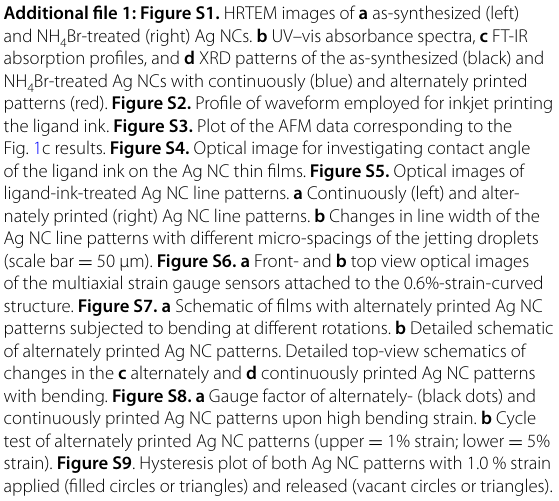
the ligand ink. Figure S3. Plot of the AFM data corresponding to the Fig. 1c results. Figure S4. Optical image for investigating contact angle of the ligand ink on the Ag NC thin films. Figure S5. Optical images of ligand-ink-treated Ag NC line patterns. a Continuously (left) and alter- nately printed (right) Ag NC line patterns. b Changes in line width of the Ag NC line patterns with different micro-spacings of the jetting droplets (scale bar 50 μm). Figure S6. a Front- and b top view optical images = of the multiaxial strain gauge sensors attached to the 0.6%-strain-curved structure. Figure S7. a Schematic of films with alternately printed Ag NC patterns subjected to bending at different rotations. b Detailed schematic of alternately printed Ag NC patterns. Detailed top-view schematics of changes in the c alternately and d continuously printed Ag NC patterns with bending. Figure S8. a Gauge factor of alternately- (black dots) and continuously printed Ag NC patterns upon high bending strain. b Cycle test of alternately printed Ag NC patterns (upper 1% strain; lower 5% = = strain). Figure S9 . Hysteresis plot of both Ag NC patterns with 1.0 % strain applied (filled circles or triangles) and released (vacant circles or